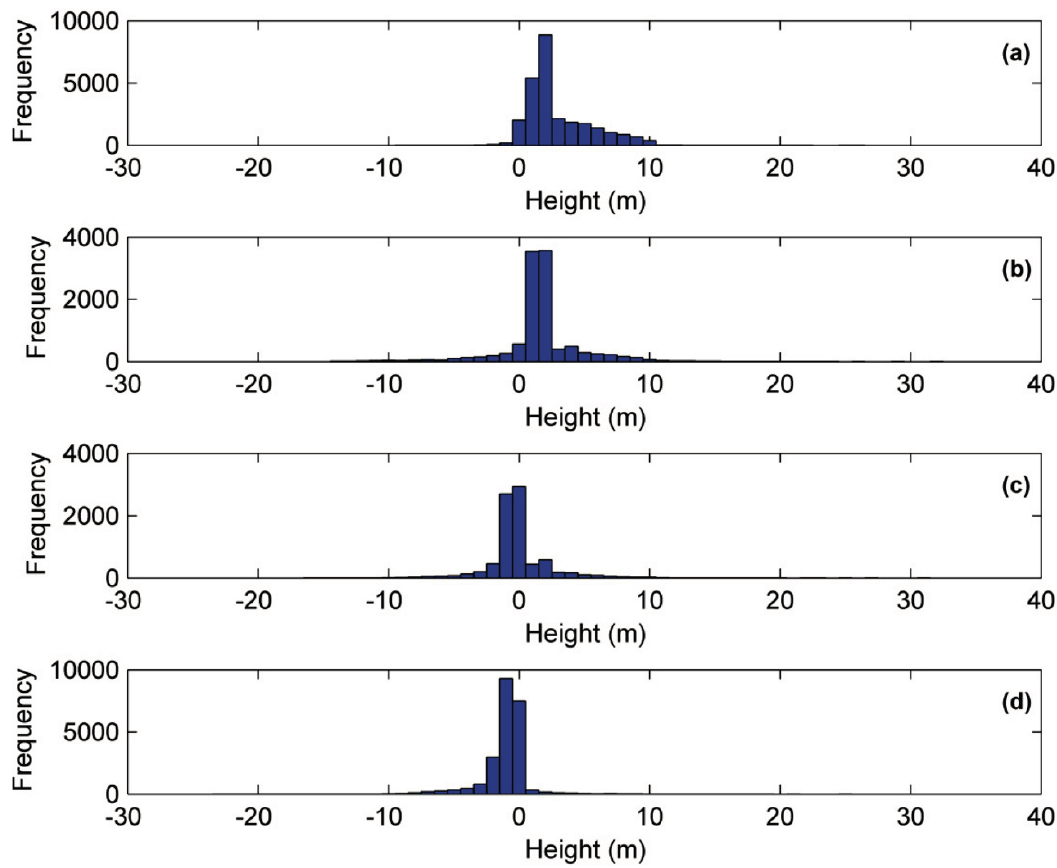
Figure 8. Changes of reclamation height (m) in the Zhoushan Islands during different time